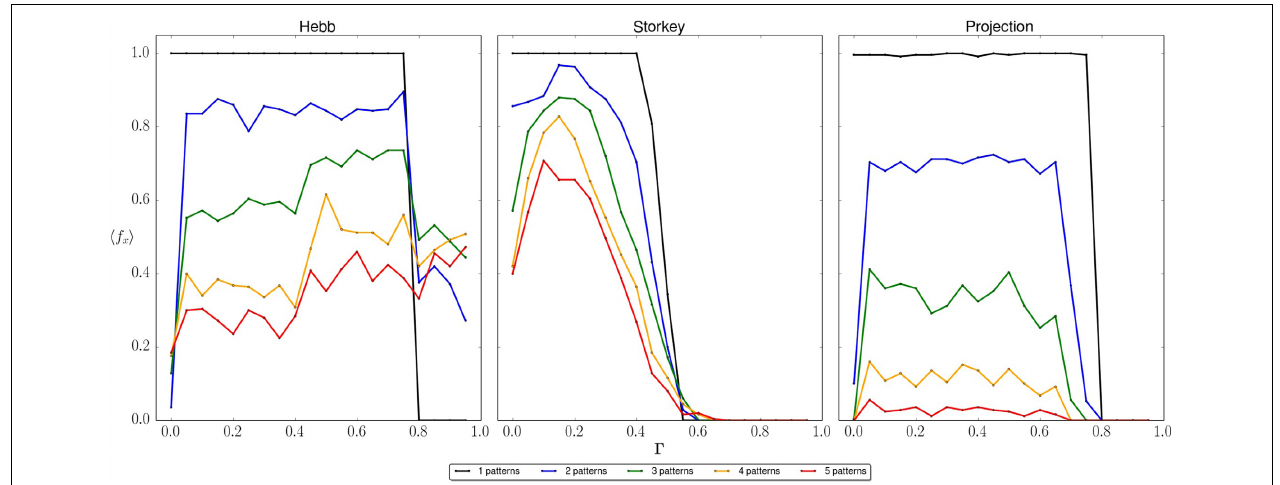
FIGURE 8 | Average probability to recall the correct memory with respect to applied bias. The average is taken over an ensemble of network instances with n = 5 neurons and p = 1 , 2 , 3 , 4, or 5 stored memories. Each panel plots the average recall success of a learning